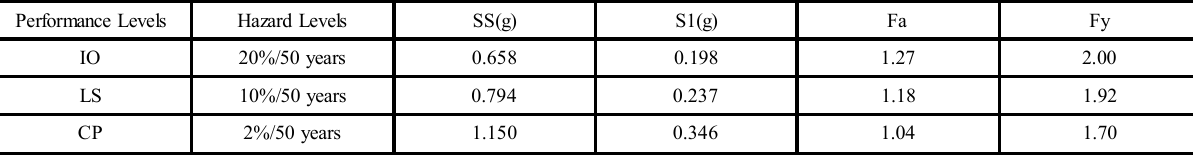
TABLE 1. SITE PARAMETERS OF DIFFERENT PERFORMANCE LEVELS FOR CLASS D